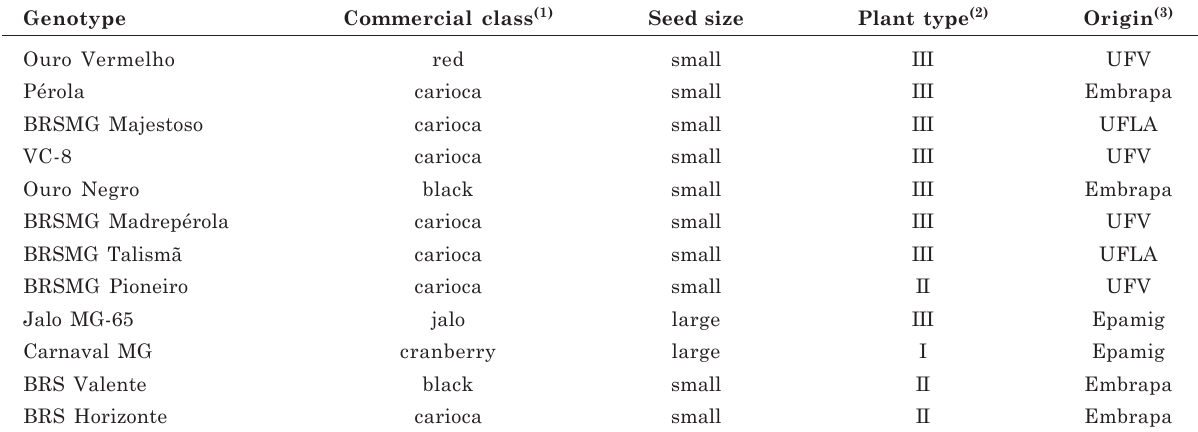
(1) carioca: beige with light brown stripes; jalo: beige. (2) I :determinate growth habit, life cycle between 65 and 75 d; II indeterminate upright growth habit; III: indeterminate semiprostrate to prostrate growth habit. (3) Institutions of origin: UFV -